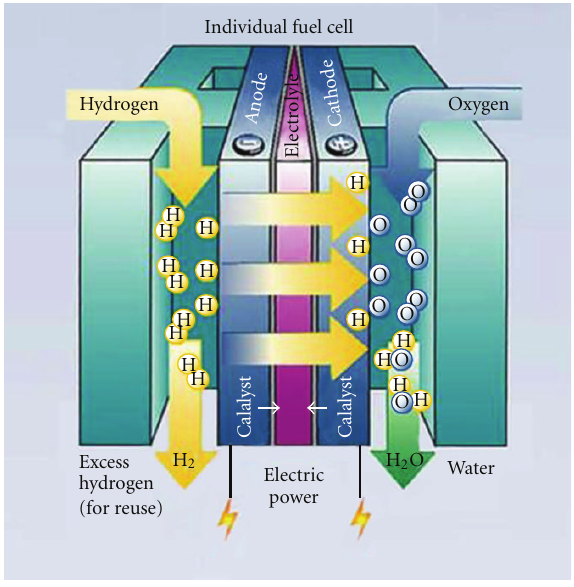
Figure 20: PEM fuel cell principle